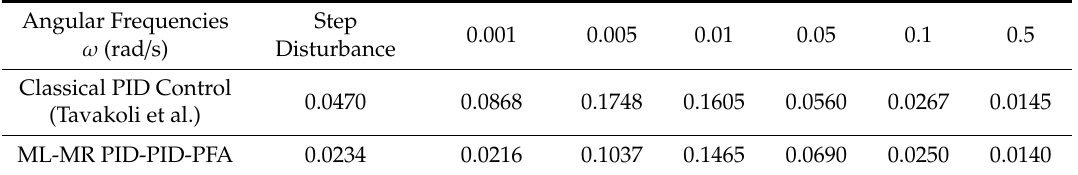
Table 1. Mean absolute error (MAE) of control error signals obtained from control simulations for step and sinusoidal waveform disturbances.